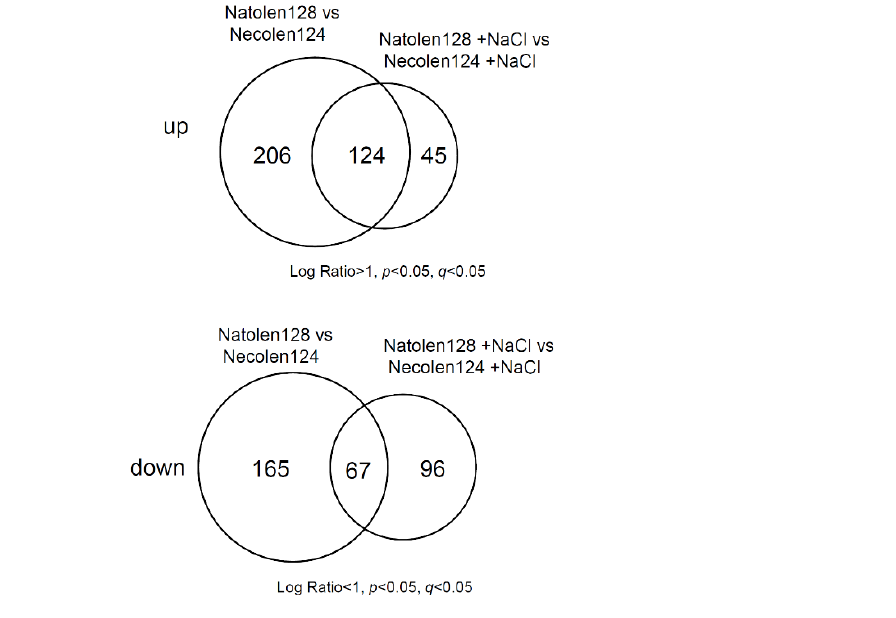
Figure 2. Gene expression profiles under Natolen128 and salinity stress treatments. The Venn diagrams show genes exhibiting up- and down-regulated expression in response to Natolen128 and Necolen124 treatments under control and high-salinity stress conditions. Each treatment was performed using 20 plants, with three biological replicates.